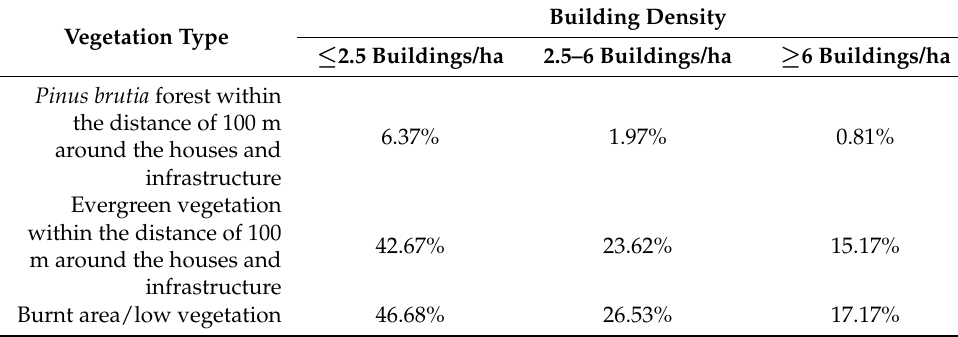
Table 3. Distribution of the WUI area within the zone of 100 m around the buildings, based on the building density and the type of the forest vegetation, and the percentages of the WUI area they